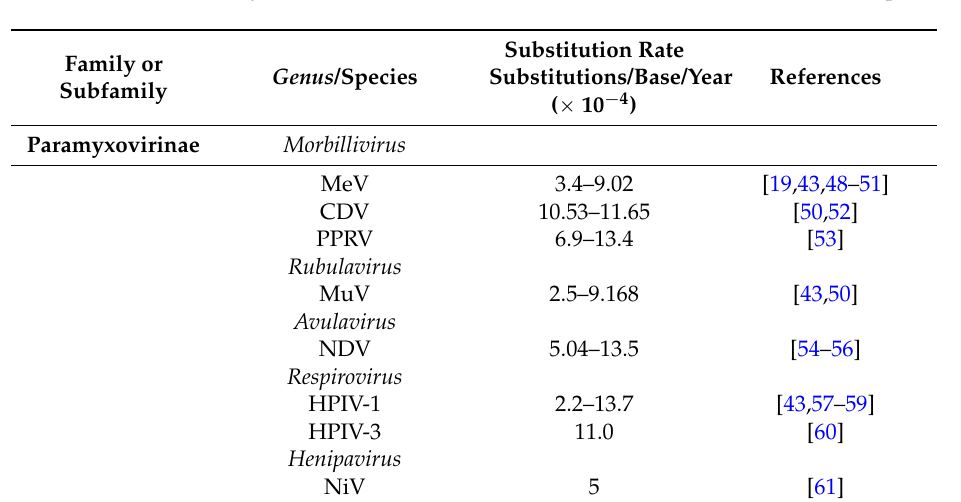
Table 1. Reported substitution rates for RNA viruses. The range of substitution rates encompasses reported measurements made from any gene or entire genome sequence for the indicated